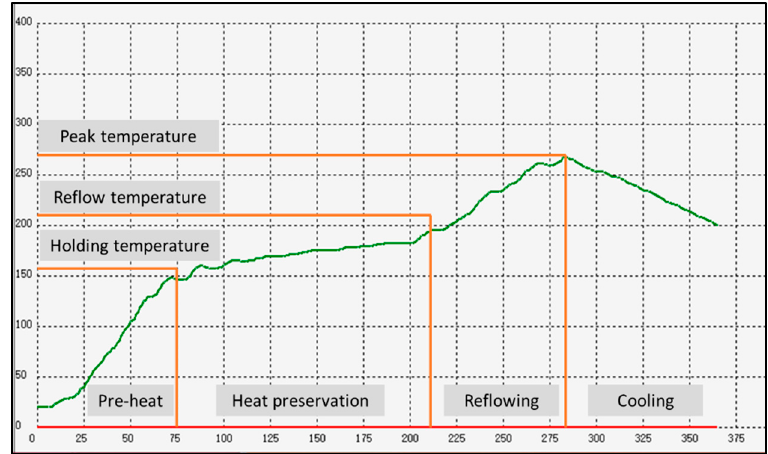
Figure 2. Reflow profile during the reflow soldering process.